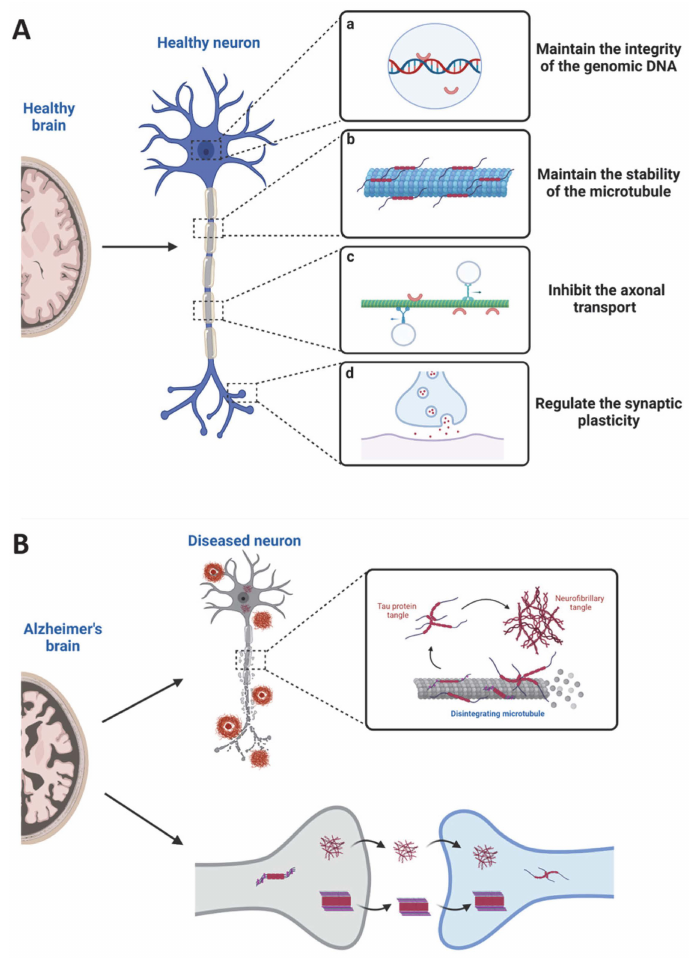
Figure 2. Biological functions of tau in the CNS. ( A ). In the physiological state. Tau protein plays different roles according to its subcellular localization in normal, healthy neurons. In nuclei, tau may function to maintain the integrity of the genomic DNA (a). In the axon, tau maintains the microtubule’s stability and inhibits axonal transport (b and c). In the dendrite, tau functions to regulate synaptic plasticity (d). ( B ). In the pathological state. Under certain stress conditions, the normal tau undergoes hyperphosphorylation and is detached from the microtubule to form tau fibrils and, eventually, the NFTs, leading to neurodegeneration. Meanwhile, NFTs are released from the diseased neurons and uptaken by the neighbor healthy neuron, spreading the disease through prion-like propagation in the